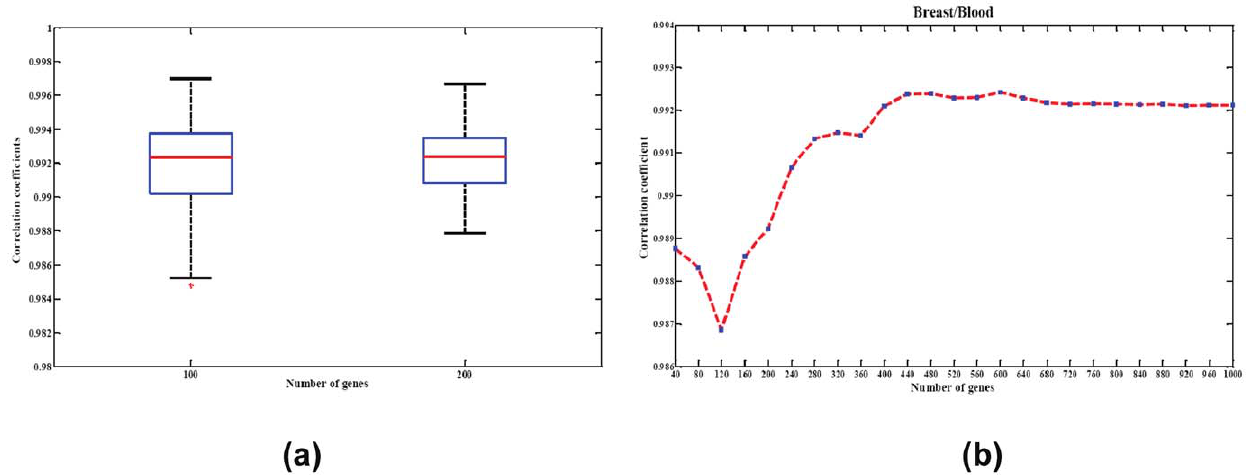
Figure 4. Robustness of the signature matrix. (a) Boxplot displaying robustness of chosen signature matrix to gene content. The correlation coefficient distribution (Y axis) is depicted for signatures composed of 100 or 200 randomly selected differentially expressed probesets. (b) Deconvolution performance across a range of signature sizes. The experiment is conducted by increasing the number of cell-type-specific gene probes step-wisely from 40 to 1000.